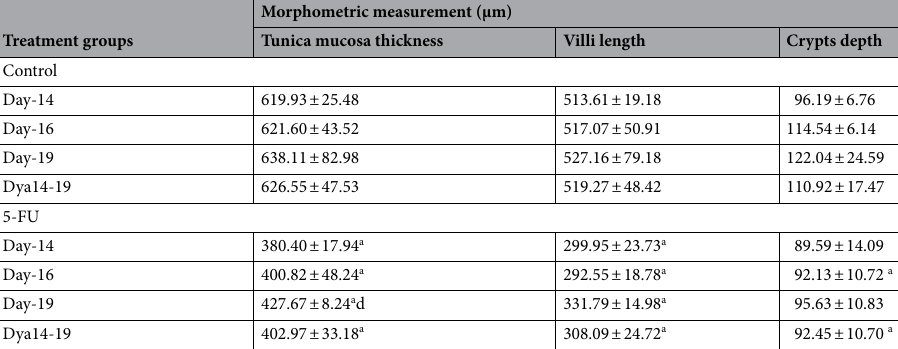
Table 1. 5-FU-induced intestinal injury. Descriptive statistics of morphometric variables of the jejunum wall of C57BL/6 mice following chemotherapy (5-FU) treatment. Groups were treated with saline (5 ml/kg/day) via tail vein (i.v.) (control group A), and 5-FU (50 mg/kg/day) i.v. (group B, 5-FU). Presented data are means ± SD of 10 representative measurement/tissue (three representative mice/group). a denoted p < 0.05 compared to control group (A).